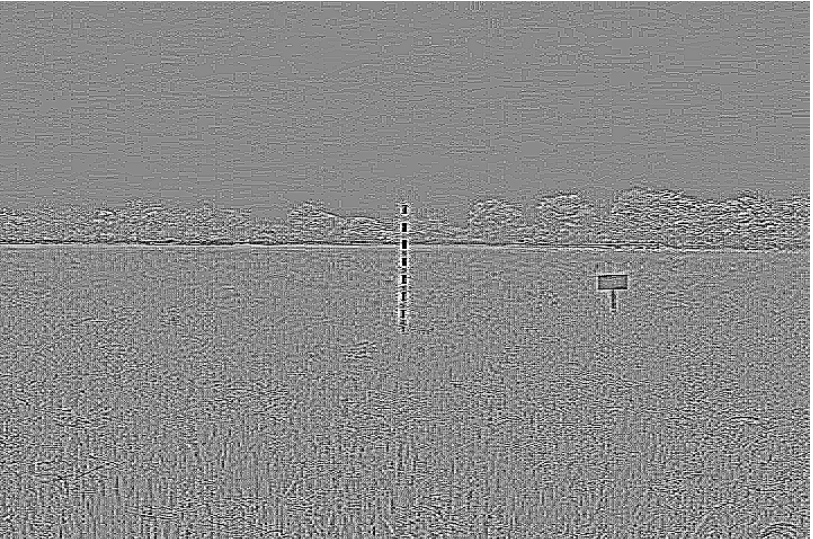
Figure 7. Filtered excess green band image with 4-neighbor Laplacian